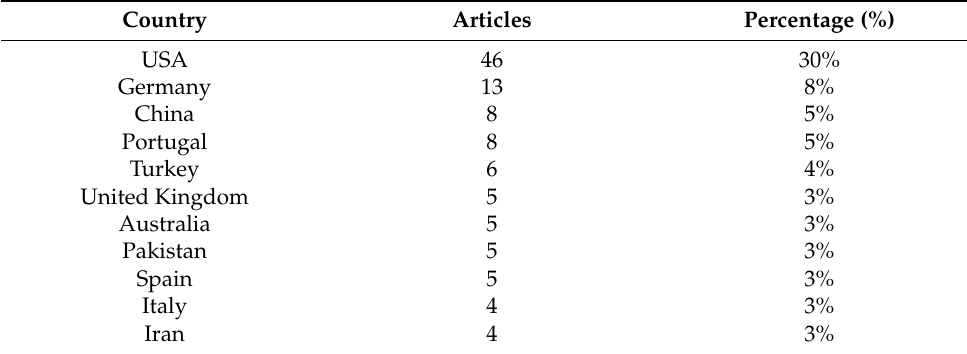
Table 5. Ten most studied countries from collected articles.